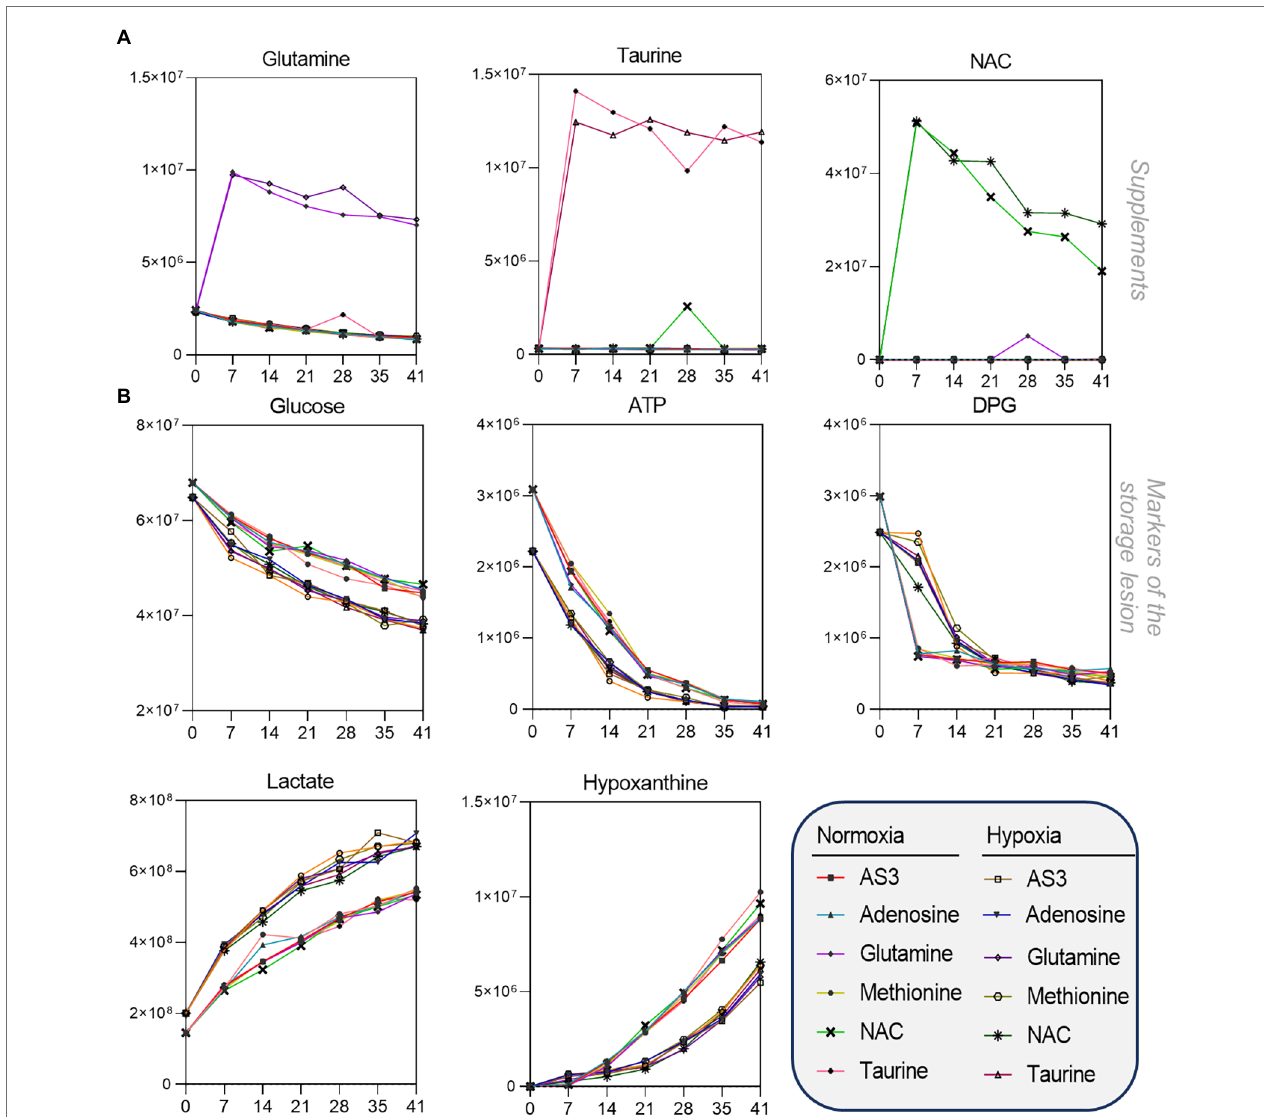
FIGURE 2 | High-throughput metabolomics detects metabolites from the supplements and recapitulates prior studies on metabolic changes during hypoxic storage Line plots in (A) highlight glutamine, taurine, and NAC as an example of three metabolites that were supplemented to AS-3, demonstrating that our methods can rapidly detect spiked in substrates and monitor them over time over thousands of samples processed in less than a day. In (B) , metabolic markers of the storage lesion (Paglia et al., 2016a; D’alessandro et al., 2017a) show a significant impact of hypoxic storage as a function of storage duration, with identical results to those reported in our previous studies on the impact of hypoxic storage on glycolysis (Reisz et al., 2016) and purine oxidation (e.g., hypoxanthine; Nemkov et al., 2018b). No major impact of any of the experimental supplements on these metabolites was